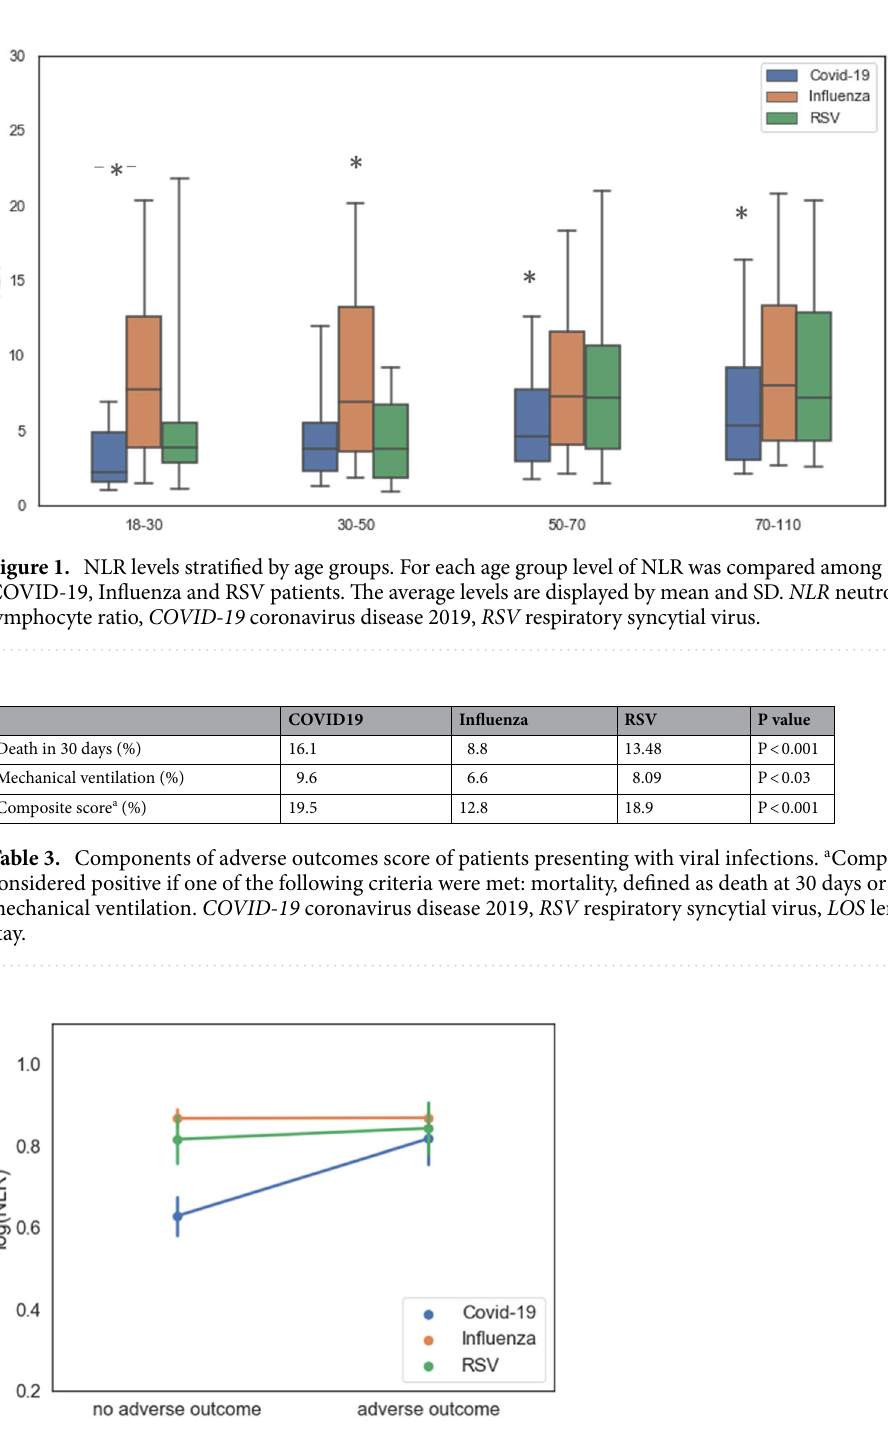
Figure 2. Two-way analysis of variance (ANOVA), using log-transformed NLR levels as the dependent variable, comparing the association between NLR values and adverse outcomes among COVID-19, Influenza and RSV patients. NLR neutrophil-to-lymphocyte ratio, COVID-19 coronavirus disease 2019, RSV respiratory syncytial